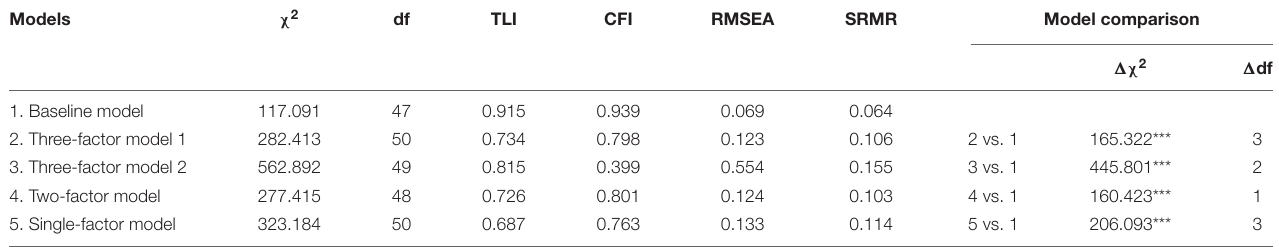
TABLE 1 | Results of confirmatory factor analysis.